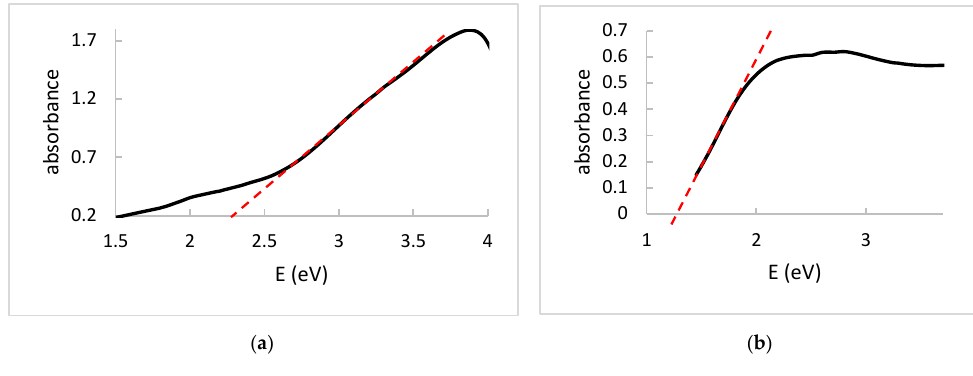
Figure 4. Absorbance spectrum of ( a ) InSe ( b ) Sb 2 Se 3 .